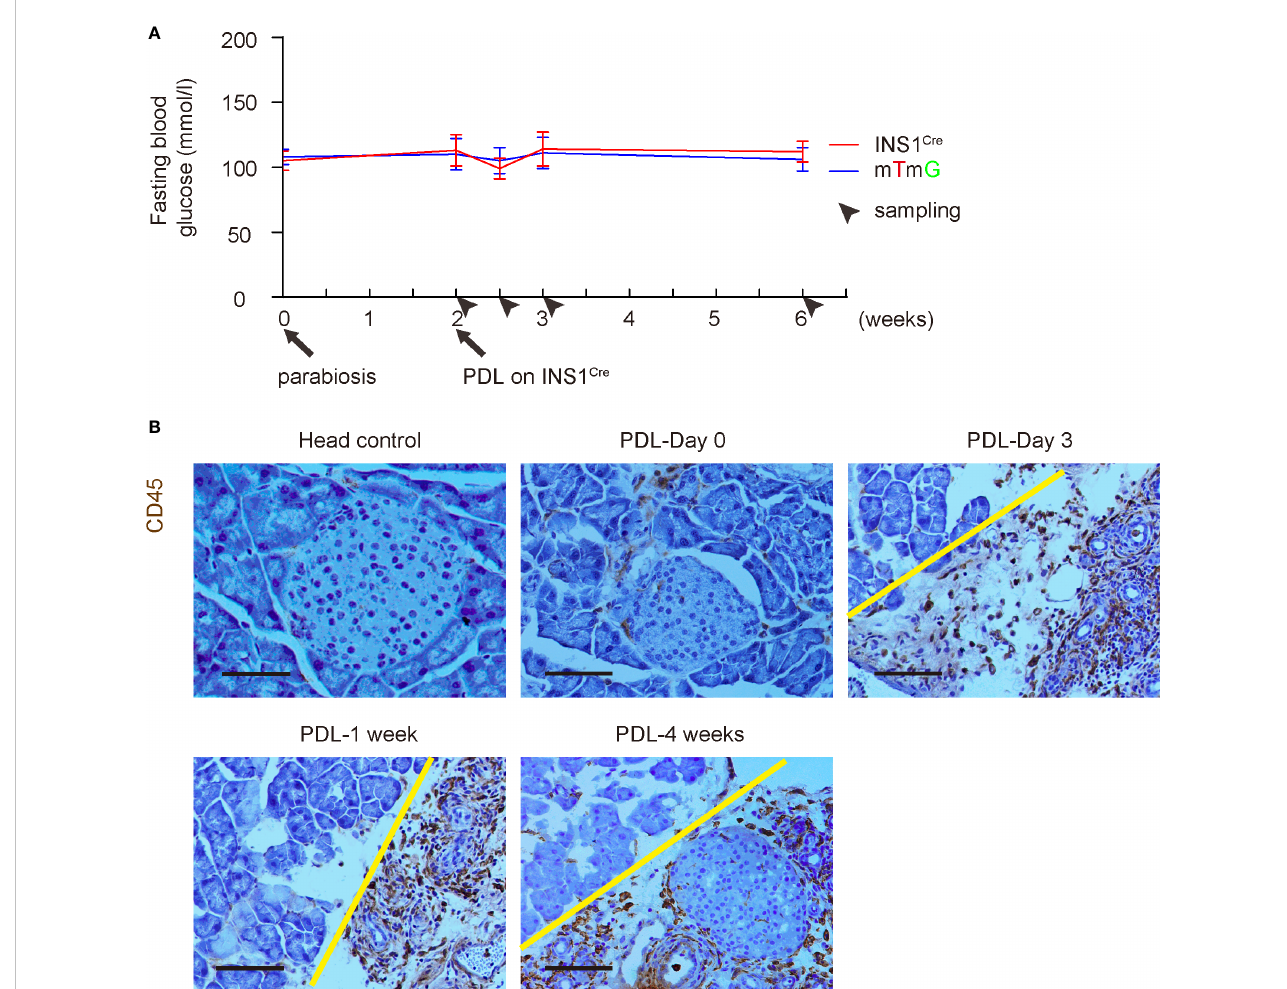
FIGURE 3 PDL does not alter blood glucose in either mouse after parabiosis. (A) Fasting blood glucose levels in both mice after parabiosis/PDL. (B) Representative immunohistochemical images for CD45 staining. Head control, a control of non-ligated PDL-head from the INS1 Cre knock-in mouse (PDL 1week). Others are from the ligated PDL-tail from the INS1 Cre knock-in mouse at different time points. Yellow line separated head (left) from tail (right) part of the pancreas. Scale bars are 100